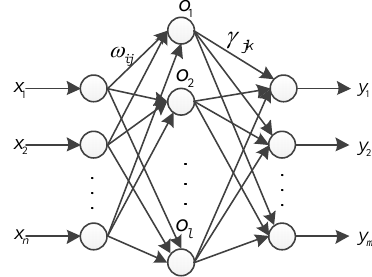
Figure 6. The network structure of ELM.